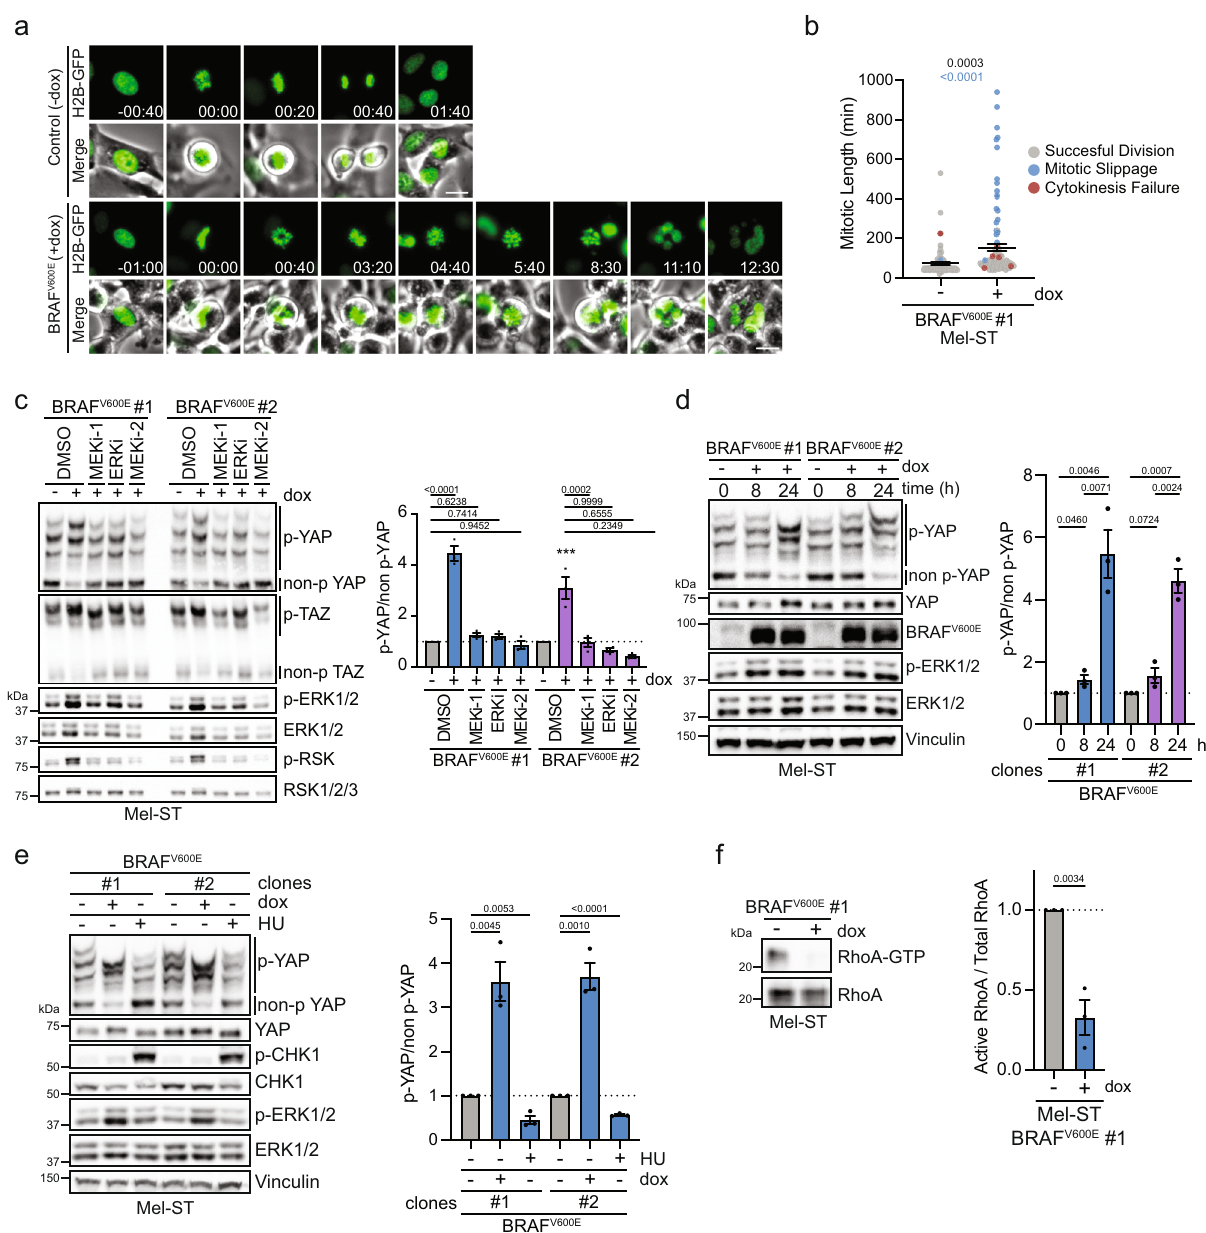
Fig. 4 Prolonged MAPK activation leads to cytoskeletal defects and Hippo activation. a Representative fl uorescence and phase-contrast images from a live-cell video of dox-inducible BRAF V600E Mel-ST cells expressing the chromosome marker H2B-GFP (green) cultured ± dox (scale bar = 25 µ m, hh:mm). b Plot of mitotic duration and fate of individually tracked mitoses from ( a ) ( n > 80 mitoses per condition from two independent experiments, graph shows mean ± SEM, dots represent individually tracked mitoses, black P value represent mitotic duration signi fi cance, two-tailed unpaired t test, blue P value represent signi fi cance for difference in frequency of whole-genome doubling events, two-sided Fisher ’ s exact test). c Left, IB of indicated dox-inducible BRAF V600E Mel-ST cell lines cultured ± dox for 24 h along with indicated drugs at the following doses: ERKi (20 nM), MEKi-1 (10 µ M), MEKi-2 (20 nM); right, intensity quanti fi cation of YAP phos-tag ( n = 3 independent experiments, graph shows mean ± SEM, one-way ANOVA with multiple comparisons). d Left, IB of dox-inducible BRAF V600E Mel-ST cell lines cultured ± dox for indicated time; right, intensity quanti fi cation of YAP phos-tag ( n = 3 independent experiments, graph shows mean ± SEM, two-tailed unpaired t test). e Left, representative IB of dox-inducible BRAF V600E Mel-ST cell lines treated ± dox for 24 h or with 1 mM hydroxyurea for 6 h; right, intensity quanti fi cation of YAP phos-tag ( n = 3 independent experiments, graph shows mean ± SEM, two- tailed unpaired t test). f Representative IB of RhoA-GTP pulldown in indicated dox-inducible BRAF V600E Mel-ST cell line ± dox; right, intensity quanti fi cation of RhoA-GTP to total RhoA ( n = 3 independent experiments, graph shows mean ± SEM, two-tailed unpaired t test). Source Data are provided as a Source Data fi